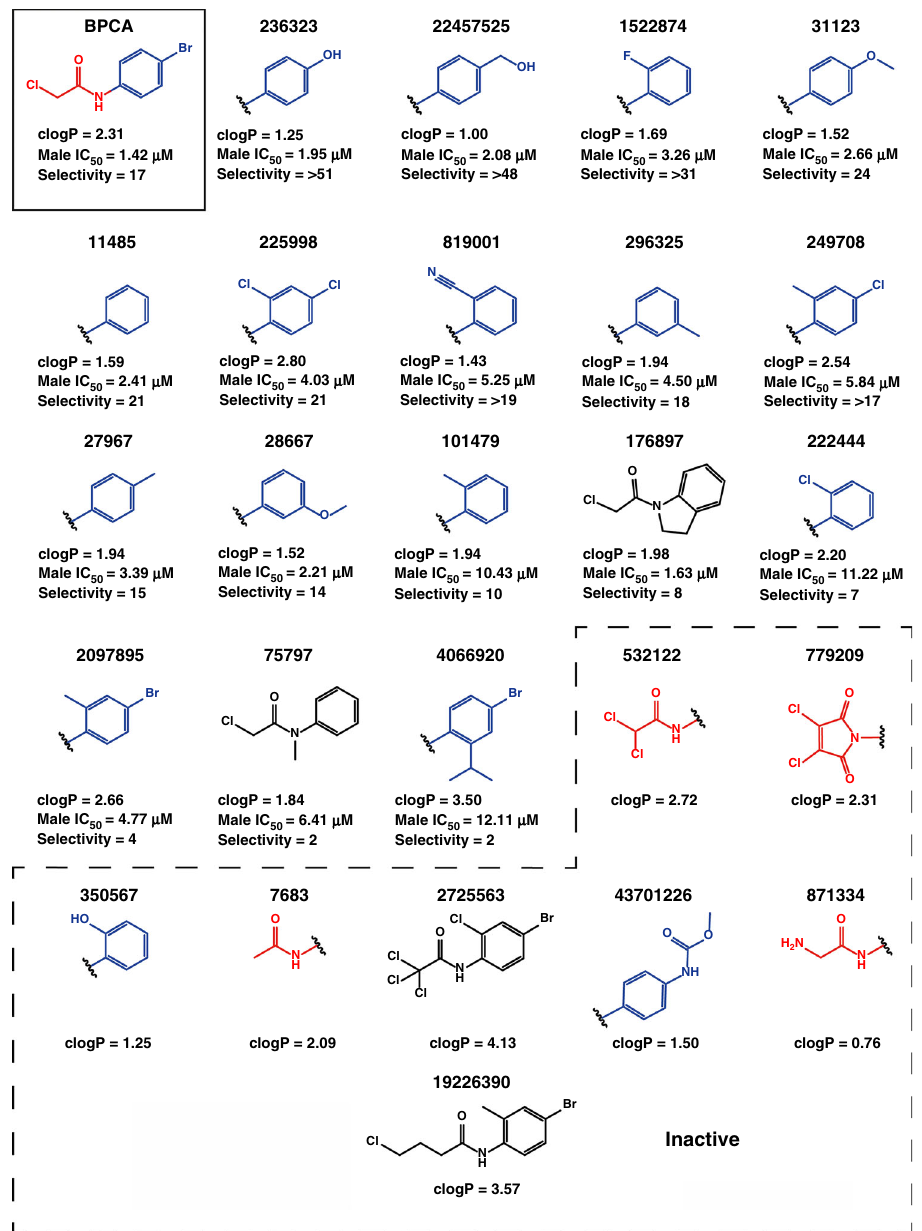
Fig. 6 Structure – activity relationship between BPCA/DDD599 and analogues. Activity in the Pf DGFA male readout and parasite selectivity compared to Tox 50 in HepG2 cells shown. Red and blue groups indicate modi fi cations to respective parts of the parent molecule. Black molecules are modi fi ed in both groups. Analogue IDs correspond to PubChem ID